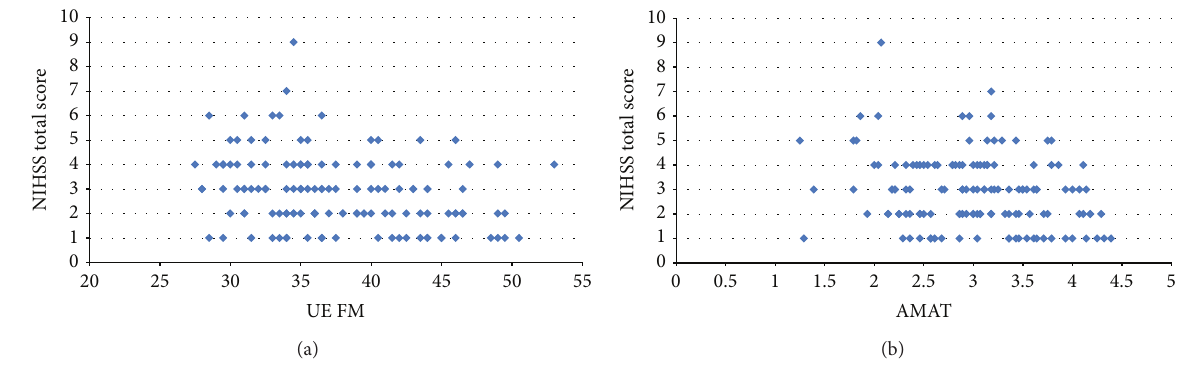
Figure 2: Comparison of subjects with zero and nonzero NIHSS scores on the UE FM and on the AMAT.